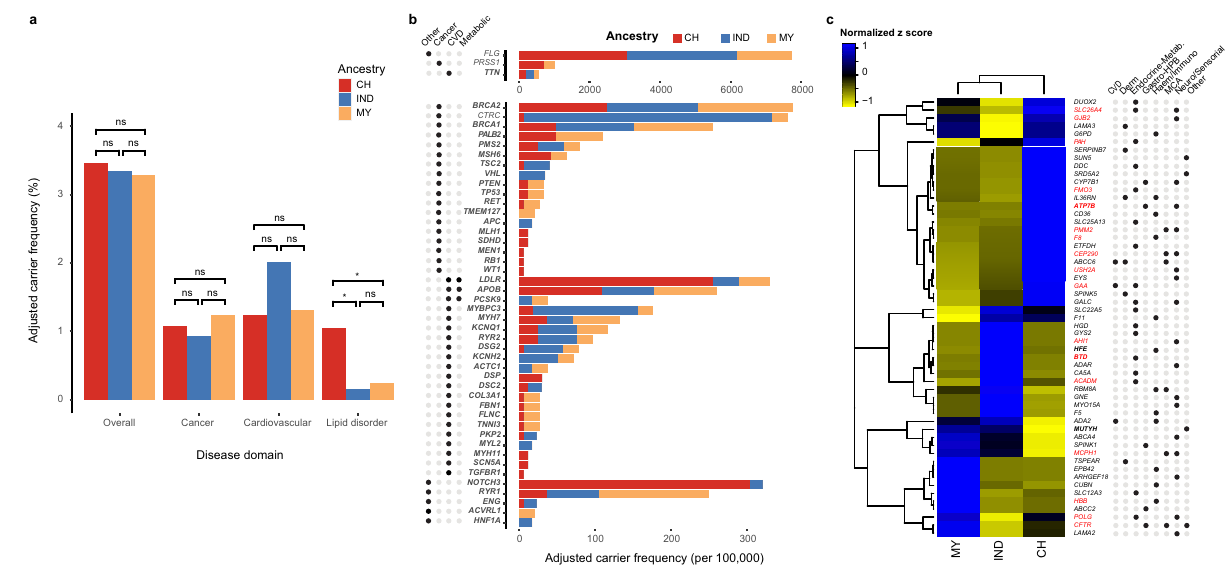
Fig. 1 | Spectrum of pathogenic variation in clinically relevant genes among Singaporeans. a Carrier frequencies of ACMG SF v3.0 genes associated with dominant disorders compared across the three main ancestry groups. The dis- orders are further sub-classi fi ed into three main disease domains for comparison (cancer, cardiovascular, lipid disorders). Carrier frequency of P/LP variants in lipid disorder genes were signi fi cantly higher among Chinese compared to Indians ( p =7.93×10 − 5 )andMalays( p =1.70×10 − 3 ).Statisticalsigni fi cancewasevaluatedby two-sided Fisher ’ s exact test, with Benjamini-Hochberg correction for multiple testing. Adjusted p <0.05 was considered signi fi cant, ns: not signi fi cant. CH: Chi- nese, IND: Indian, MY: Malay. b Differential distribution of carrier frequencies acrossancestriesfordominantlyinheritedgeneticdisordersassociatedwithACMG SF v3.0 medically actionable genes, or non-ACMG SF v3.0 genes with a carrier frequency >0.5%. c Genes of recessive conditions with signi fi cant differences in